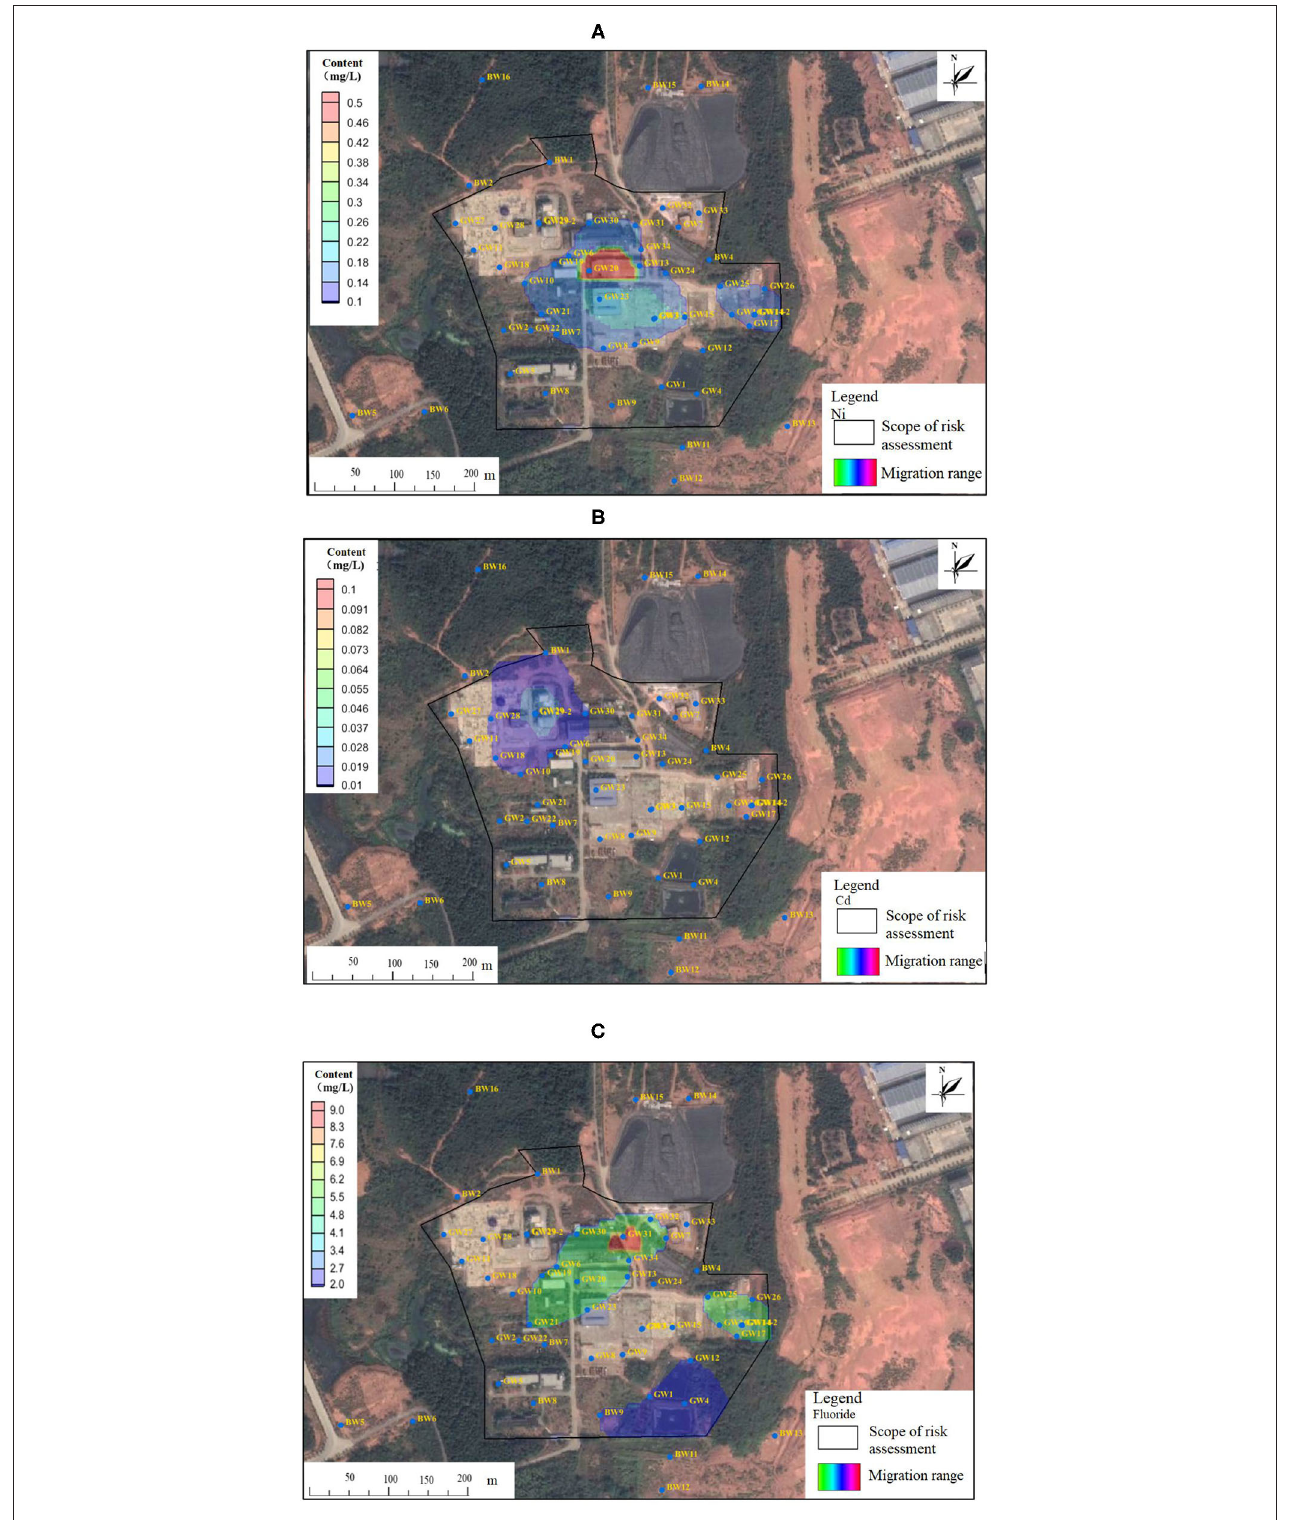
FIGURE 4 | Nickel (A) , Cd (B) , and fluoride (C) plume simulation in the next 50 years.